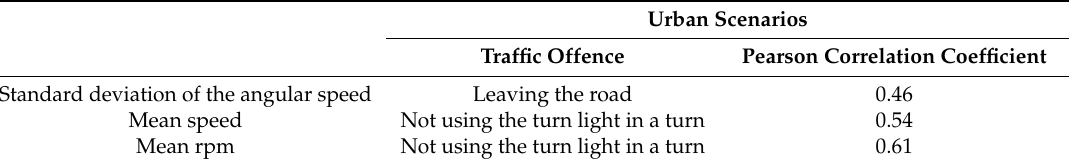
Table 3. Pearson correlation coefficients with p -values lower than 0.05 for the urban scenarios.